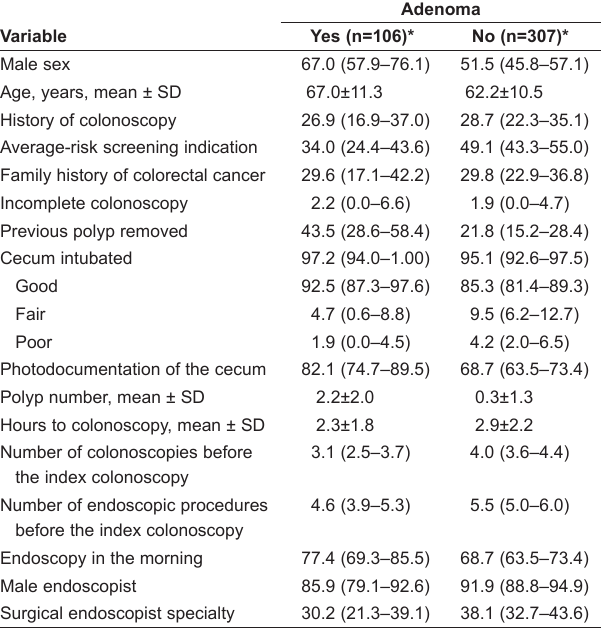
Table 3 Results of between-group comparisons for detection of at least one adenoma on screening colonoscopy